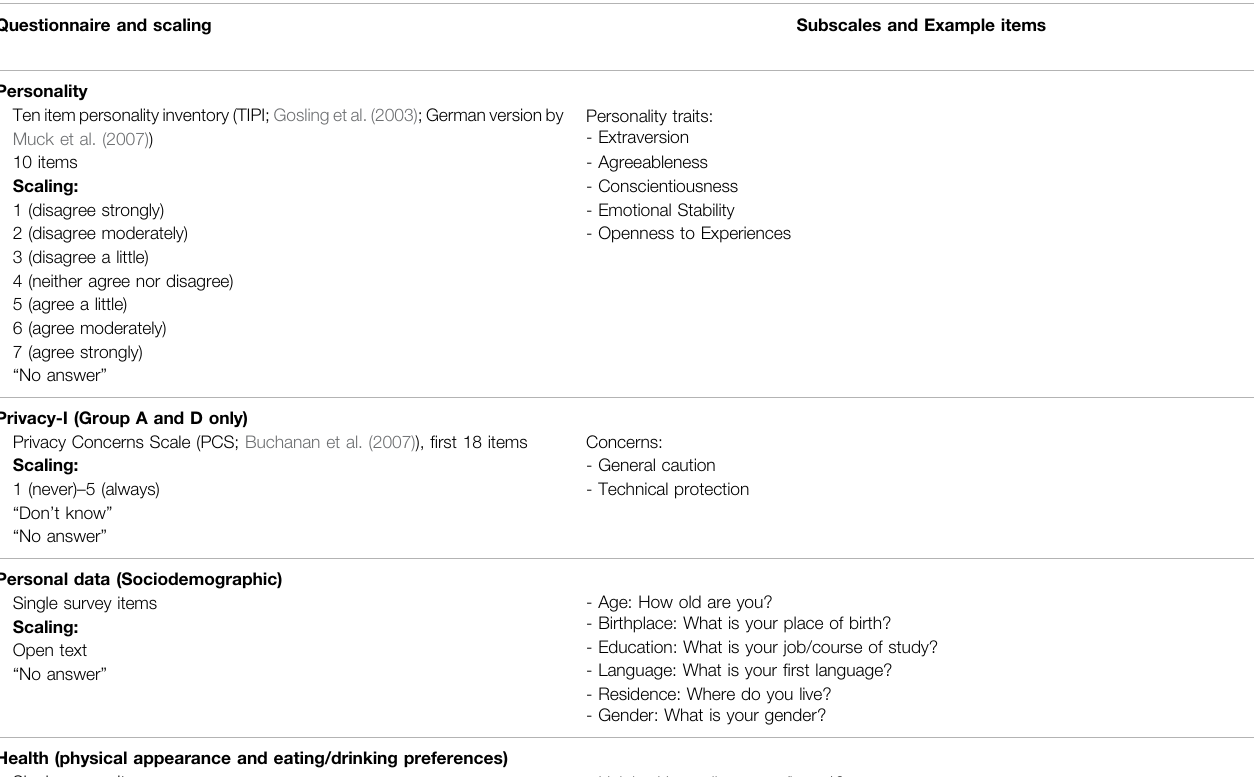
TABLE 1 | Questionnaires, scaling, and items with subscales and example items. Questionnaire and